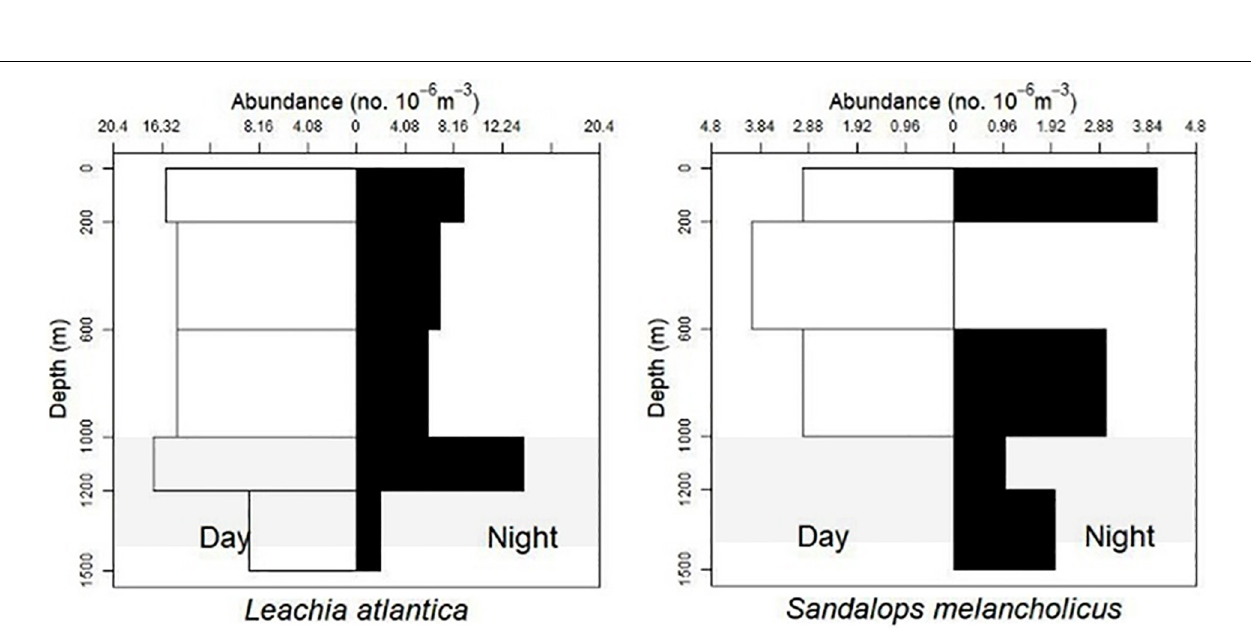
Frontiers in Marine Science |